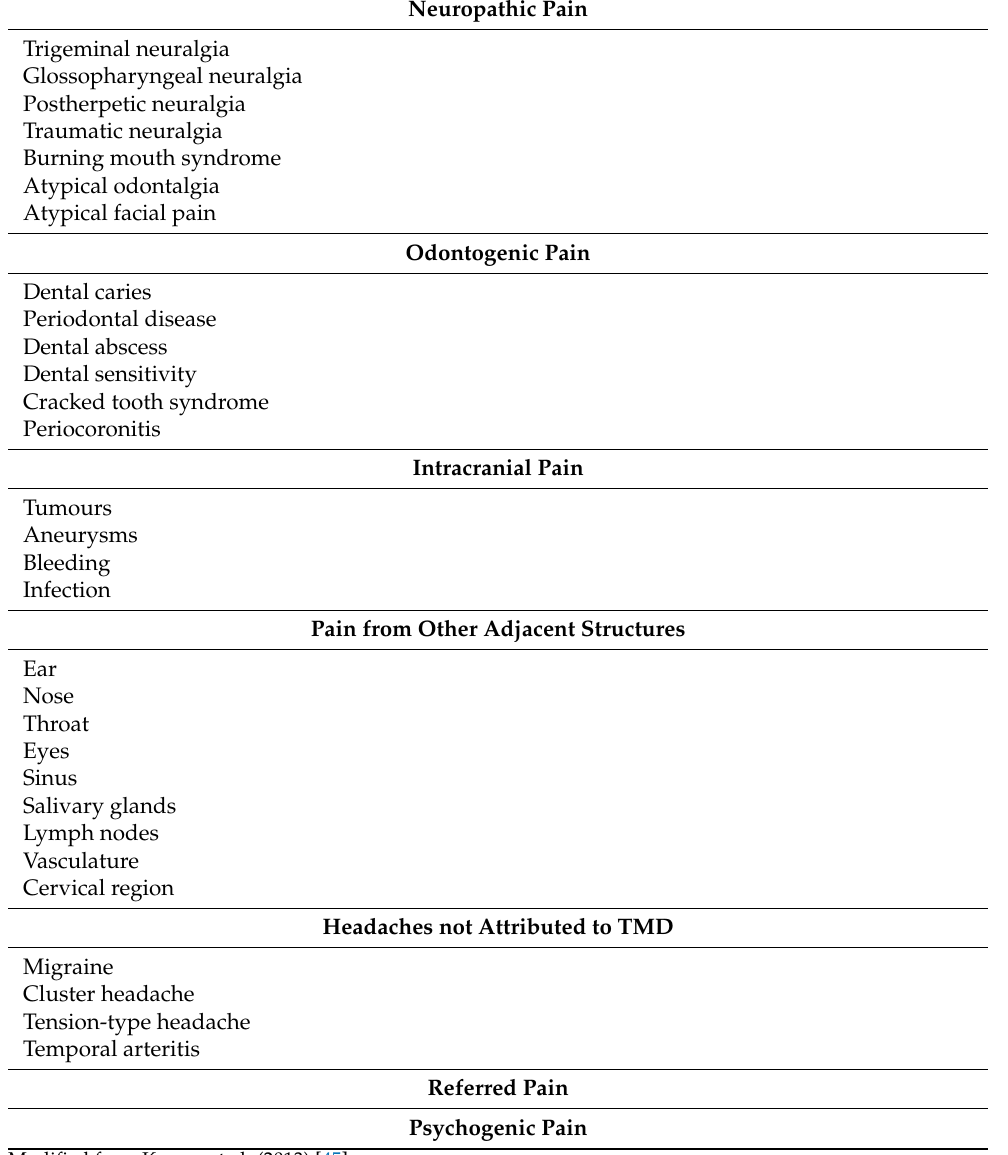
Table 3. Differential diagnosis of temporomandibular disorders (TMD)